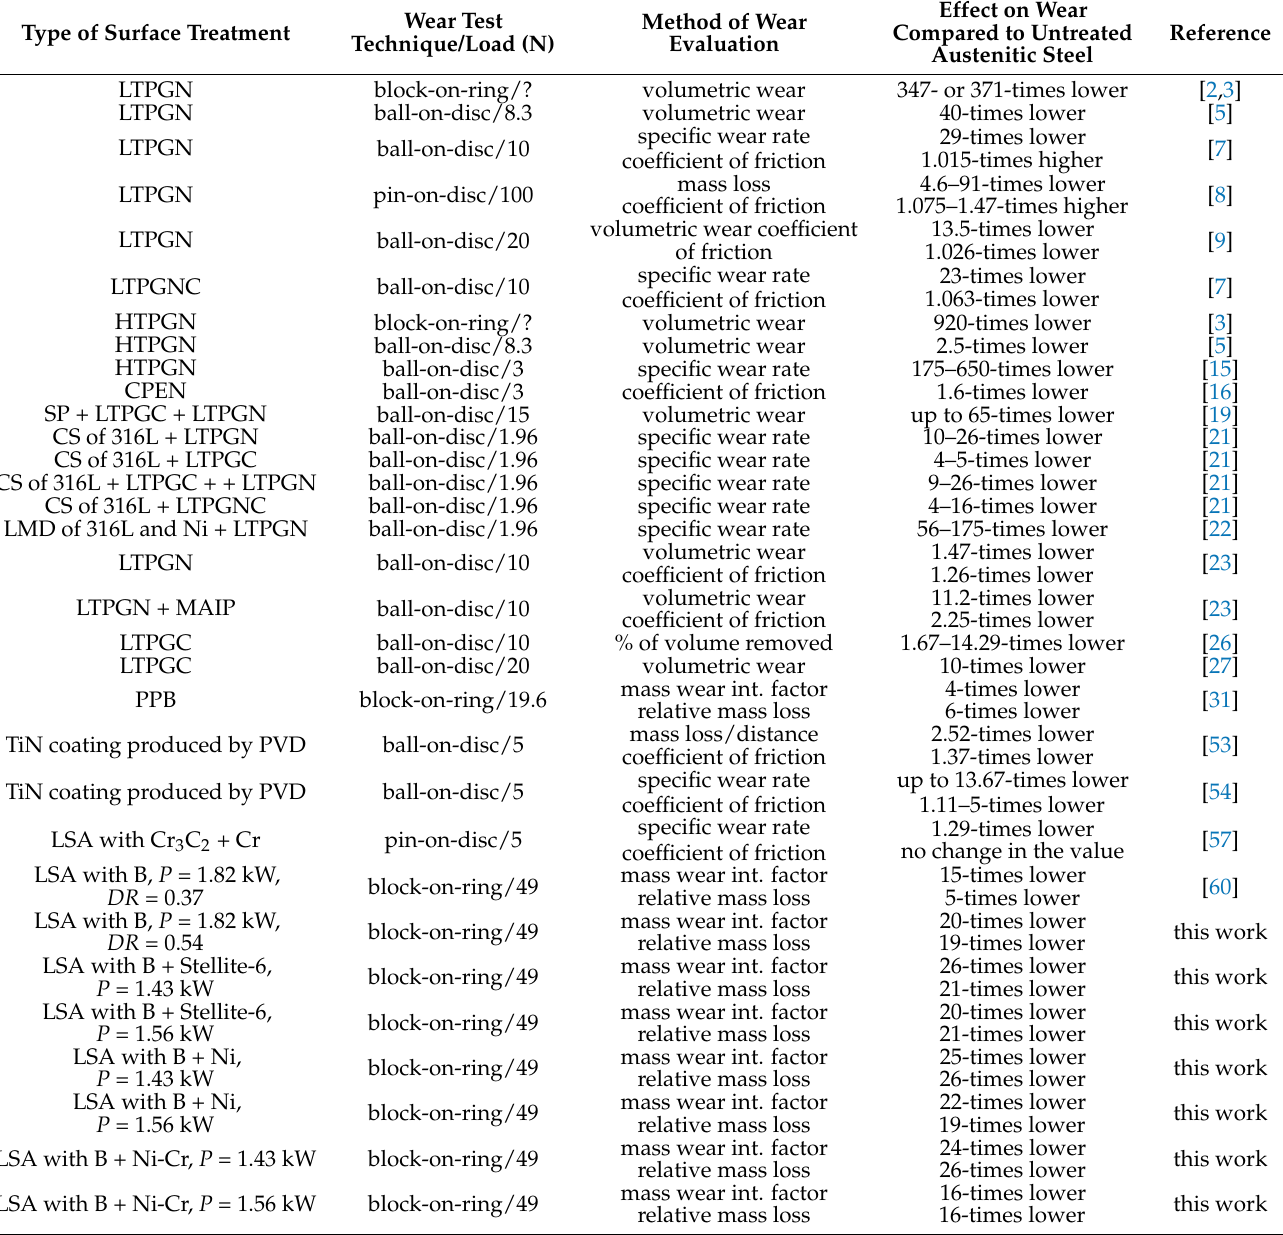
Table 3. Effect on wear in comparison with untreated austenitic steel using the various methods of wear tests and wear evaluations after the surface treatment by various physical techniques.